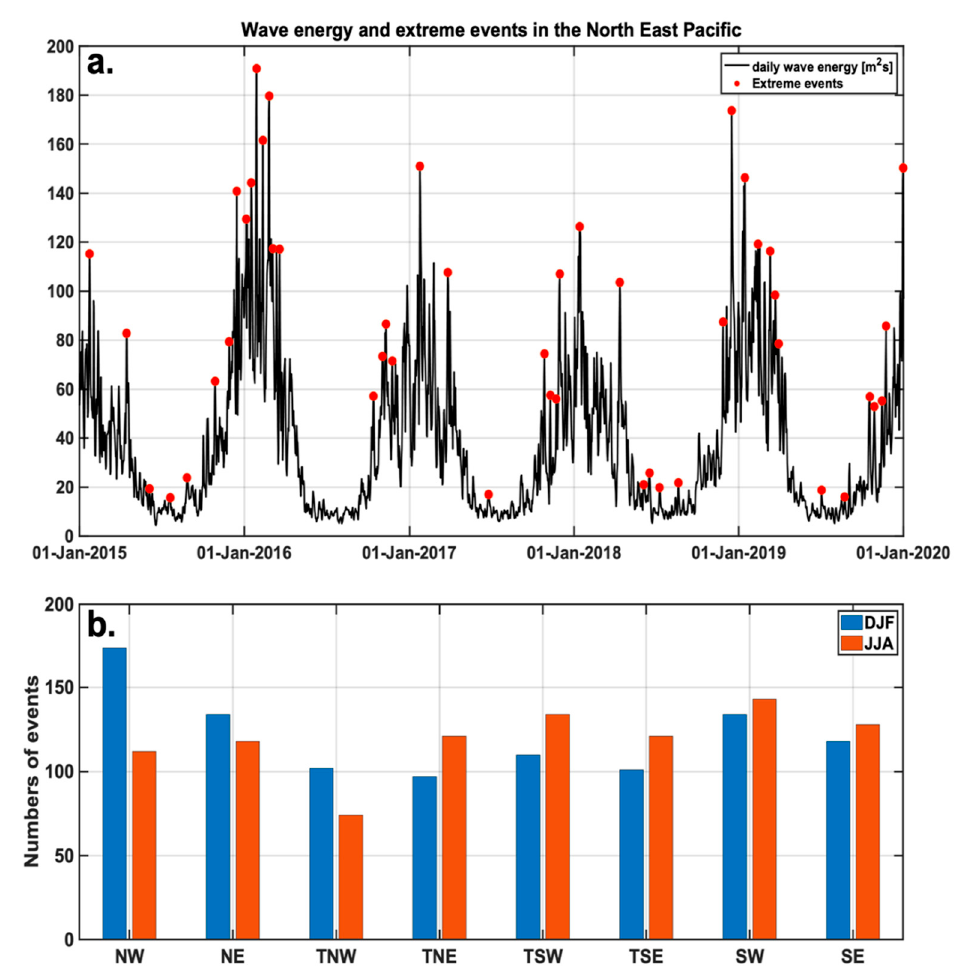
Figure 2. ( a ) Daily wave energy (H s2 T P in m 2 s) timeseries (zoomed in on the period of 2015–2019) in the Pacific North-East oceanic region (black line) and extreme wave events (red dots) identified using the method described in Section 2.3. ( b ) Total number of extreme events detected in December–February (DJF, blue bars) and June–August (JJA, orange bars) for each oceanic region.